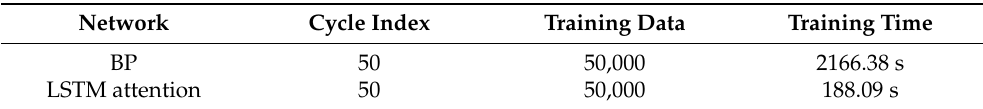
Table 6. Time complexity comparison between LSTM attention and BP